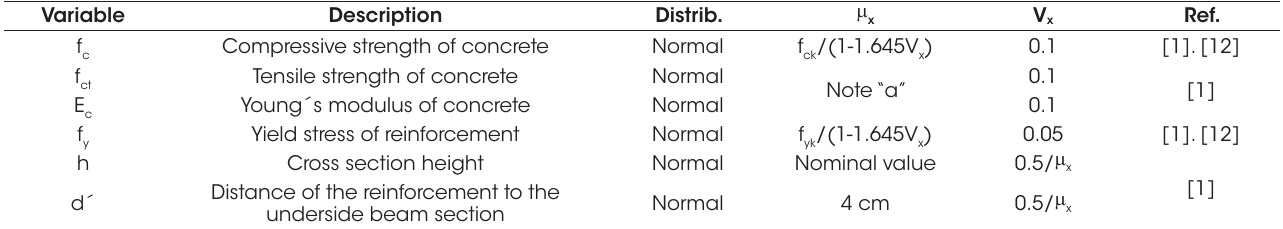
Random variables associated with resistance, used in numerical simulations